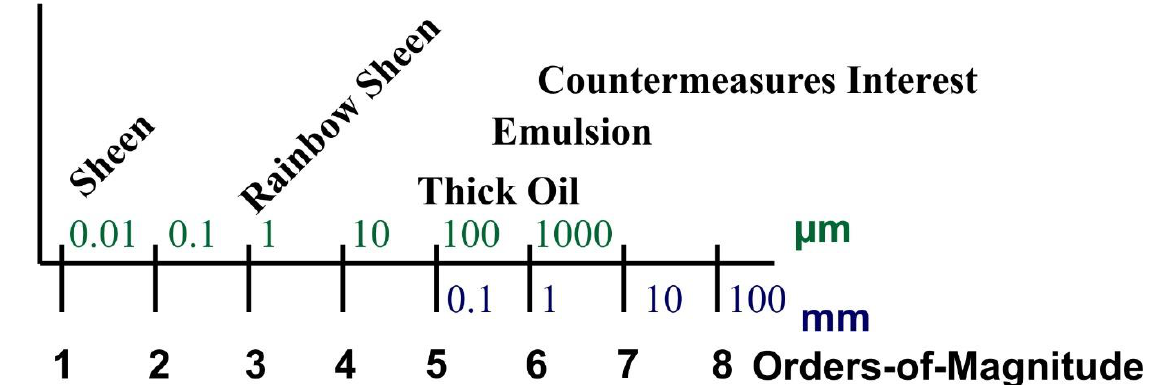
Figure 1. Illustration of the relevant oil spill thickness regimes.